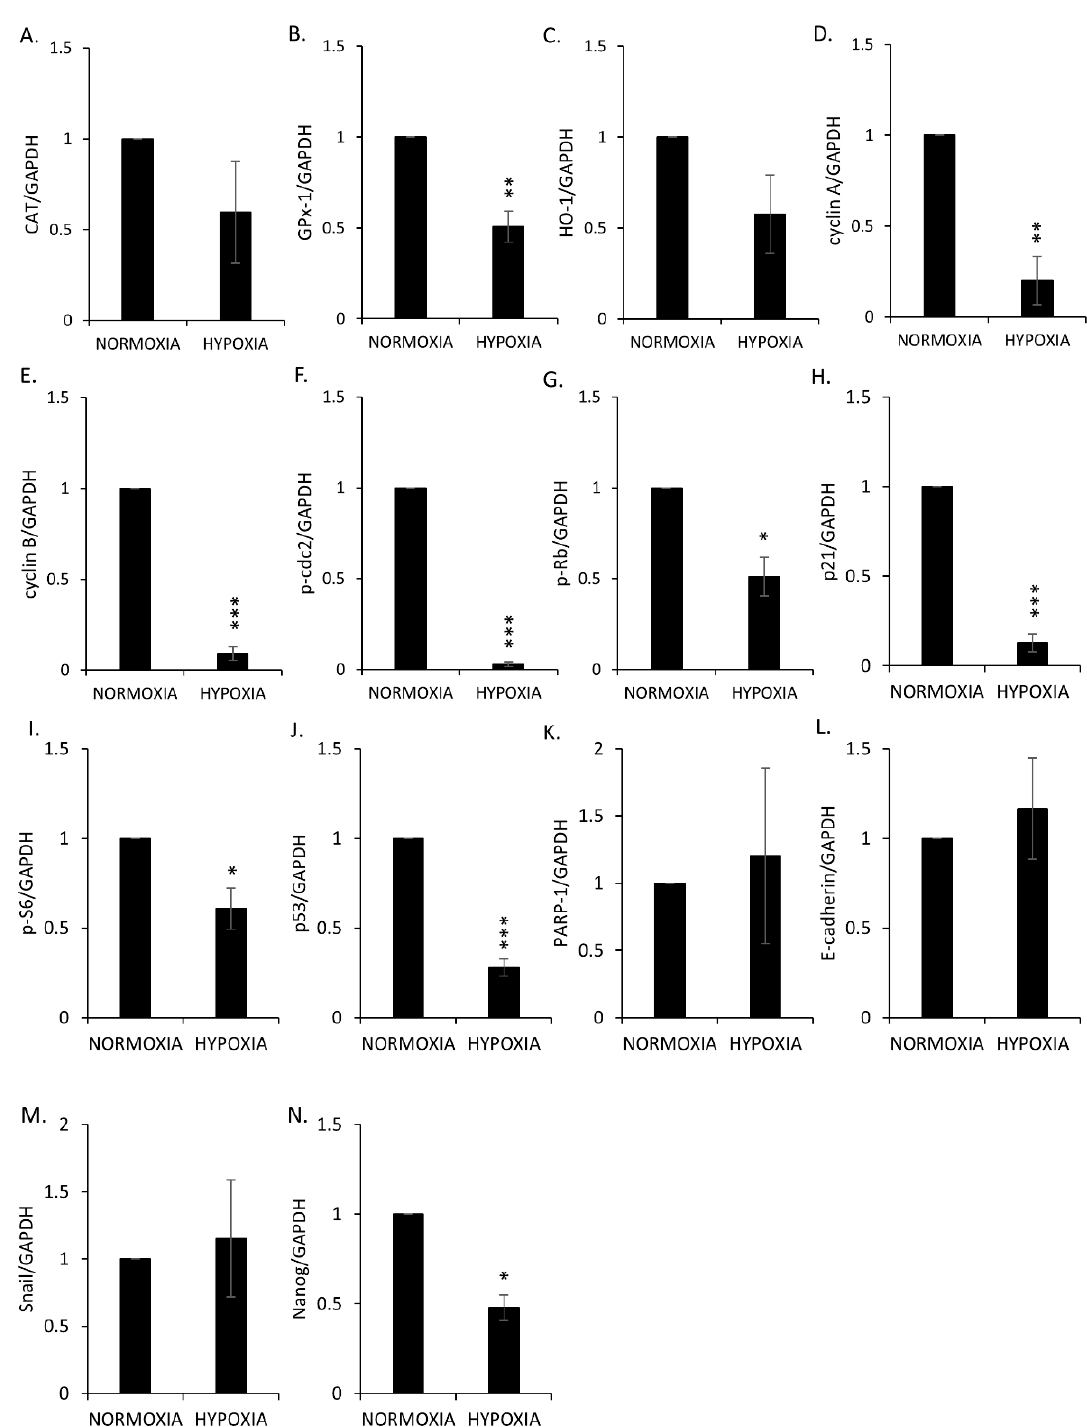
Figure A7. Evaluation of the protein expression in HCT116 cells treated with 2.5 µM IRINO in normoxia or hypoxia: antioxidative, proliferation, cell cycle inhibition, and EMT markers. Quantification is based on the densitometry analysis performed with the use of ImageJ software. Data are shown as the ratio of the protein amount to respective protein loading control (GAPDH): ( A ) CAT; ( B ) GPx-1; ( C ) HO-1; ( D ) cyclin A; ( E ) cyclin B; ( F ) p-cdc2; ( G ) p-Rb; ( H ) p21; ( I ) p-S6; ( J ) p53; ( K ) PARP-1; ( L ) E-cadherin; ( M ) Snail; ( N ) Nanog. Each bar represents mean ± SEM, n ≥ 3; * p < 0.05, ** p < 0.01, *** p < 0.001—normoxia vs. hypoxia.